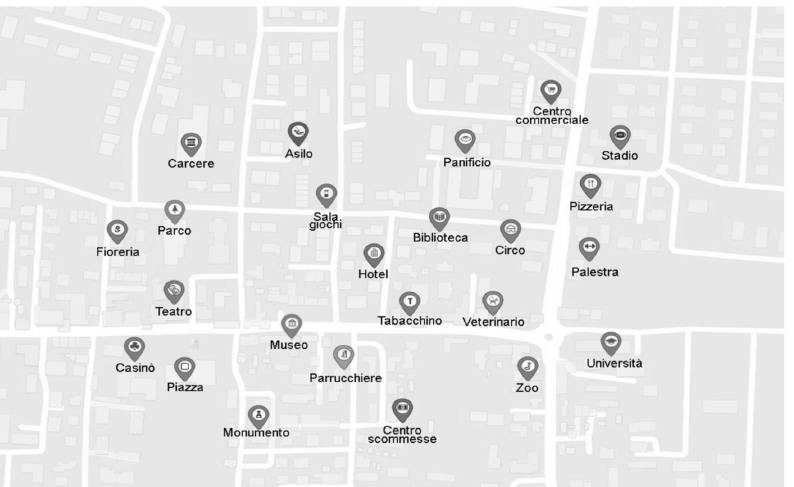
Figure 1. The map used in the map learning phase. The map comprises the following landmarks: bakery shop (“Panificio”), betting center (“centro scommesse”), casino (“casin ò ”), circus (“circo”), flower shop (“fioreria”), game room (“sala giochi”), gym (“palestra”), hairdresser (“parrucchiere”), hotel (“hotel”), kindergarten (“asilo”), library (“biblioteca”), monument (“monument”), museum (“museo”), park (“parco”), the pizzeria (“pizzeria”), prison (“prigione”), shopping center (“centro commerciale”), square (“piazza”), stadium (“stadio”), theatre (“teatro”), tobacco shop (“tabacchino”), university (“universit à ”), veterinarian (“veterinario”), zoo